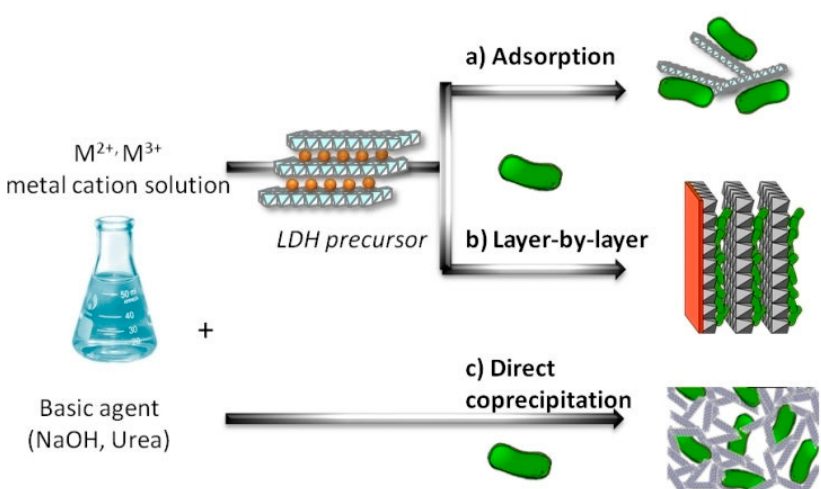
Figure 8. Schematic representation of ( a ) adsorption method, ( b ) layer-by-layer deposition and ( c ) direct co-precipitation method of layered double hydroxide (LDH). Reproduced with permission from Reference [73]. Copyrights 2018, John Wiley and Sons.